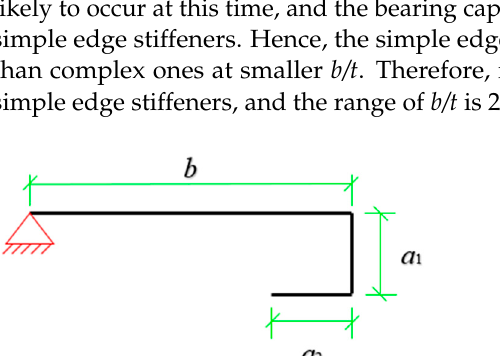
Figure 5. Analytical model for the complex edge stiffener.